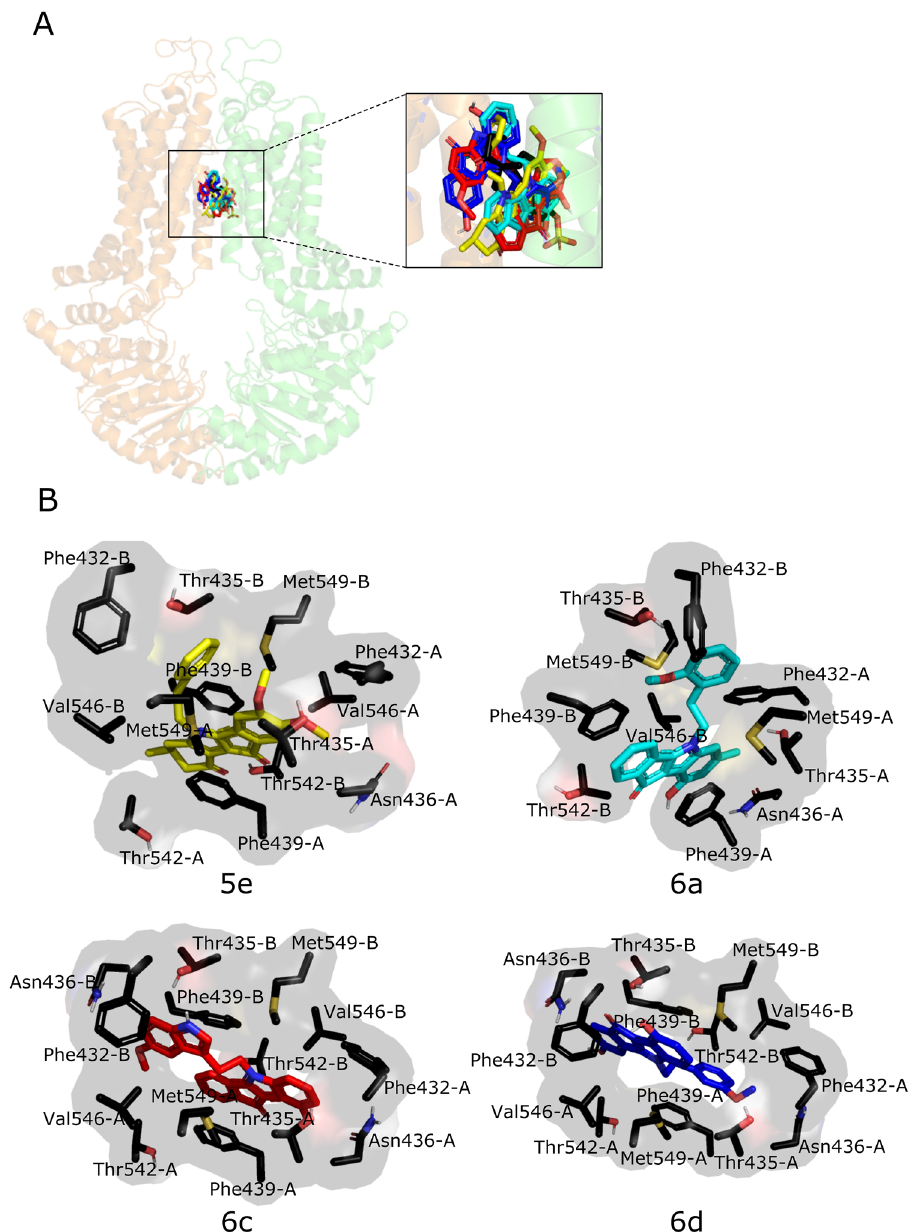
Figure 7. Docking analysis in human ABCG2 (PDB 6HCO). ( A ) Representative docking poses of the inhibitors overlapping the binding site of estrone-3-sulfate (E3S – black, 6c —red, 6d —blue, 6a —cyan and 5e —yellow), in stick representation. The two monomers are colored differently, orange (chain A) and green (chain B). ( B ) Interacting residues on the best energy score pose of the inhibitors are represented as stick models. The images were generated using the program PyMOL Molecular Graphics System, Version 1.2r3pre, Schrödinger, LLC (URL: https ://pymol